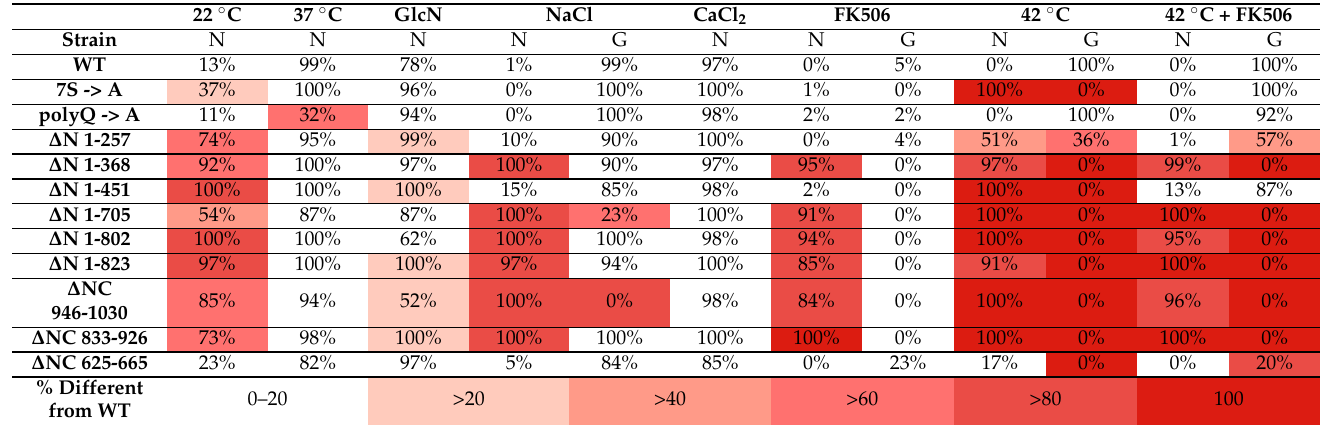
Table 1. Localization of Crz1